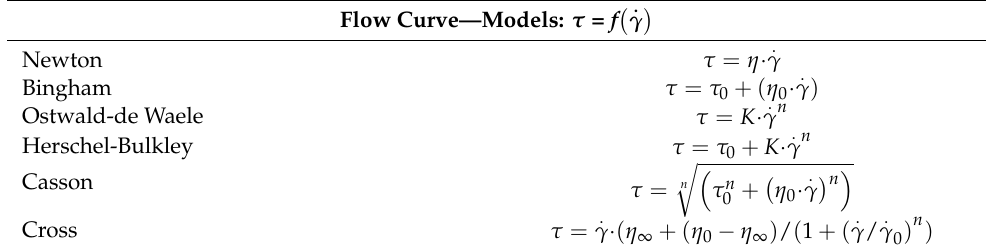
Flow Curve—Models: τ = f